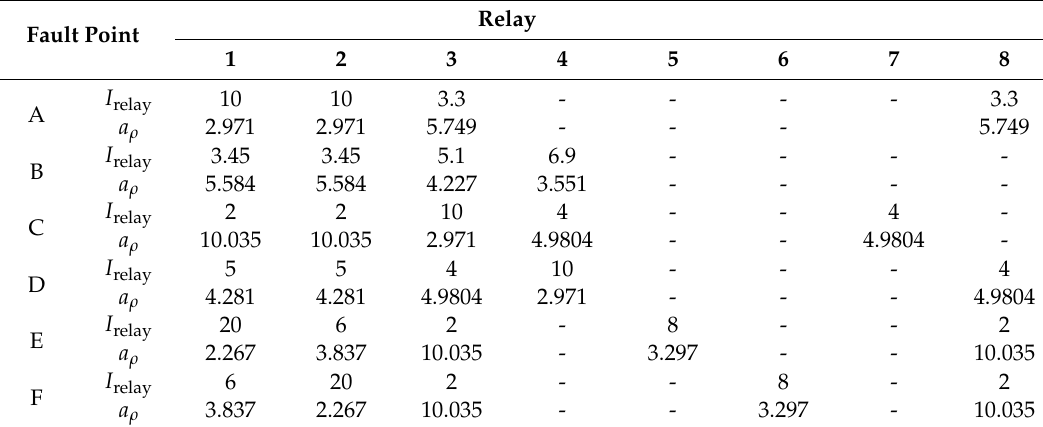
Table 2. a ρ constants and relay currents for Case